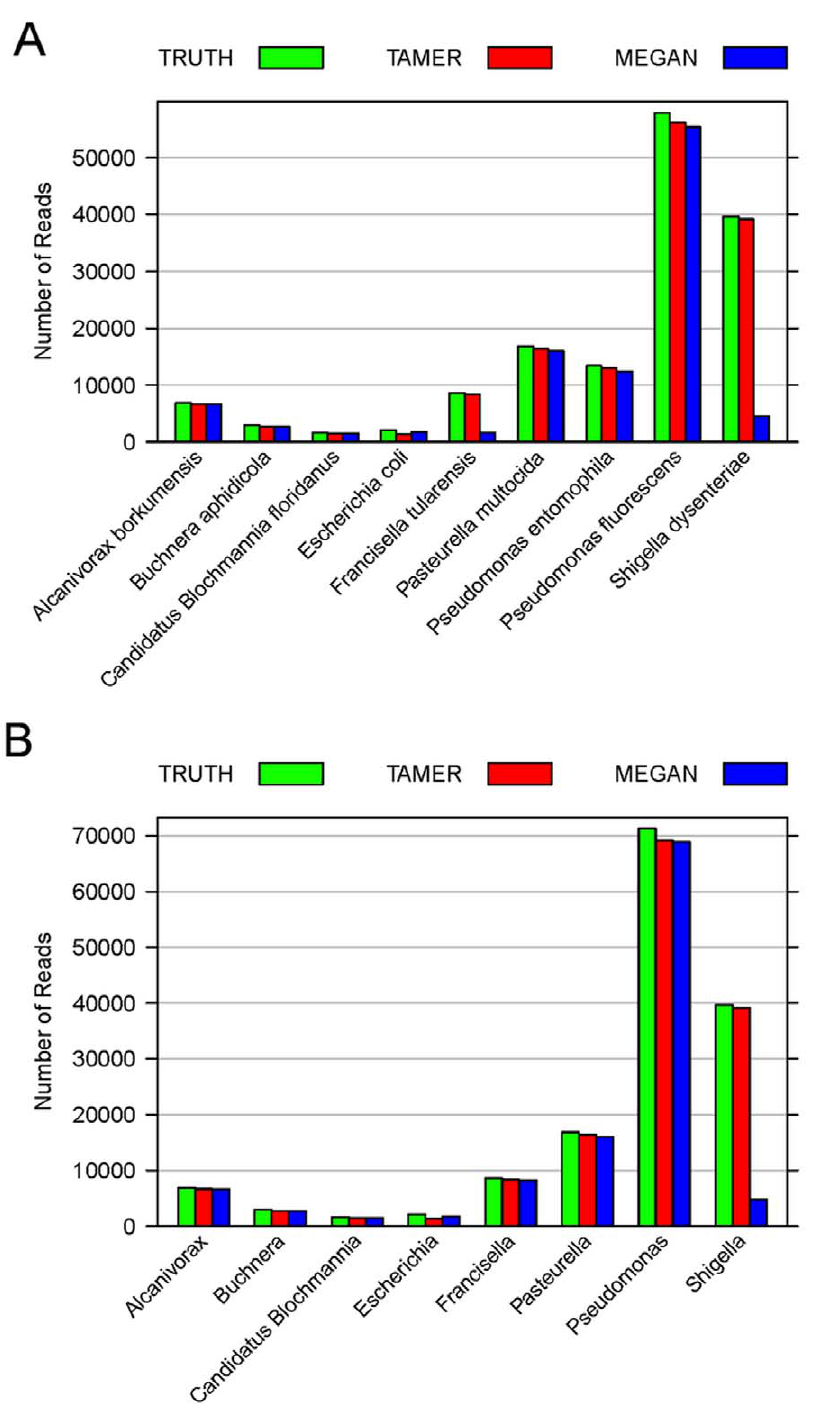
Figure 2. Reads assignment at rank Species and Genus for simMC dataset. Numbers of reads assigned to rank (A) Species and (B) Genus using TAMER and MEGAN are compared with the true values (TRUTH) for the simMC dataset with 150,000 reads and average read length of 100 bp in simulation study 1.